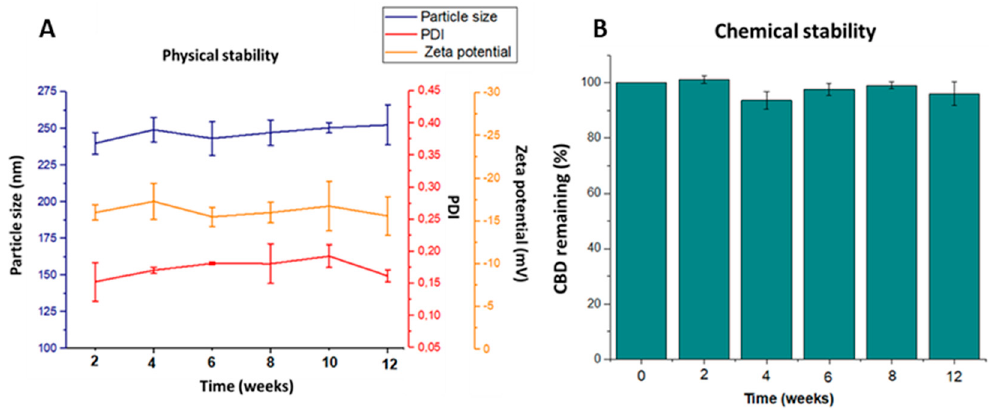
Figure 3. Physical ( A ) and chemical stability ( B ) of CBD-NPs stored at 5 ◦ C during 12 weeks ( n = 4). PDI: polydispersity index.